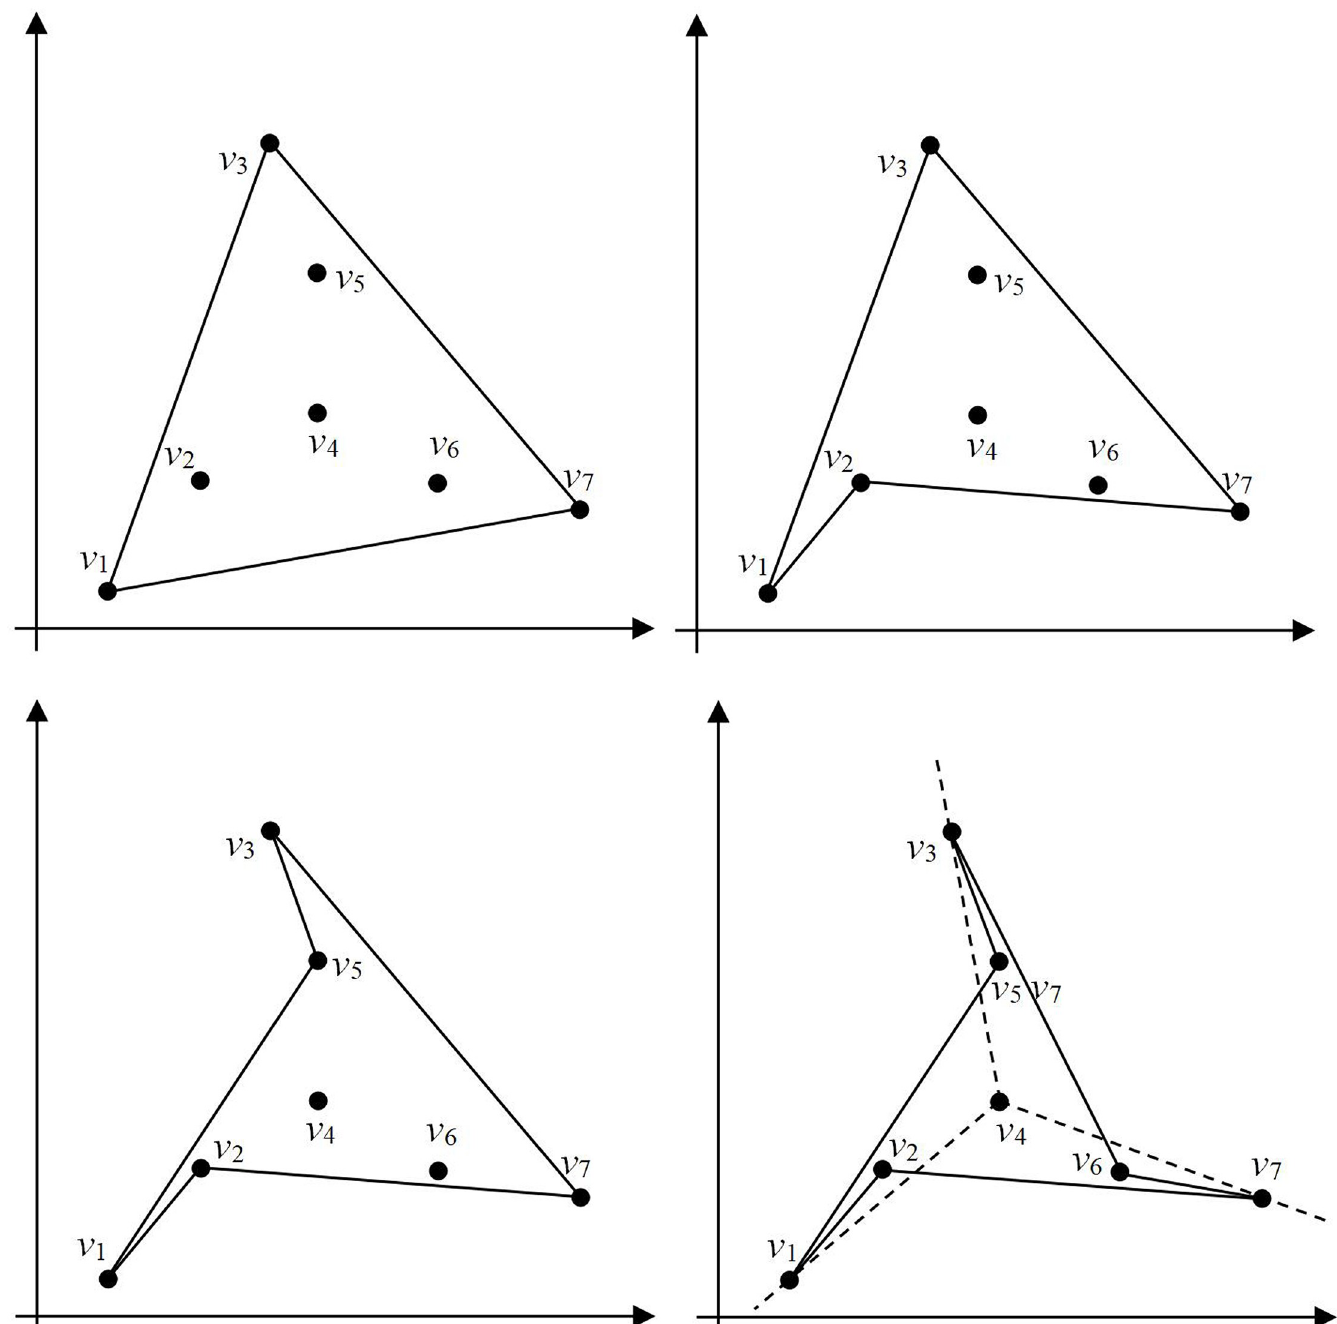
Fig 17. Polygon generation using the convex-hull construction method. (a) Polygon initialization, (b) result of one iteration, (c) result of two iterations, and (d) result of three iterations.